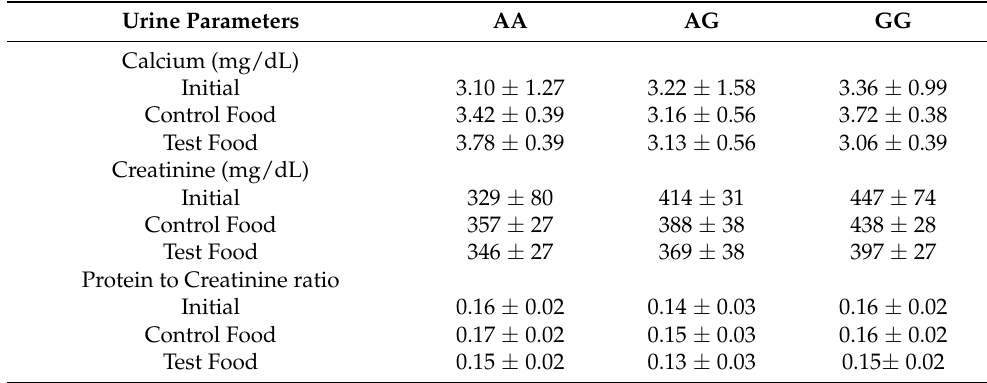
Table 6. Values (mean ± SEM) for selected urine parameters in cats with different alanine-glyoxylate aminotransferase 2 (AGXT2) single nucleotide polymorphisms (SNPs), at the end of the 28-day pre-feeding period (Initial) and after consuming control or test food for 28